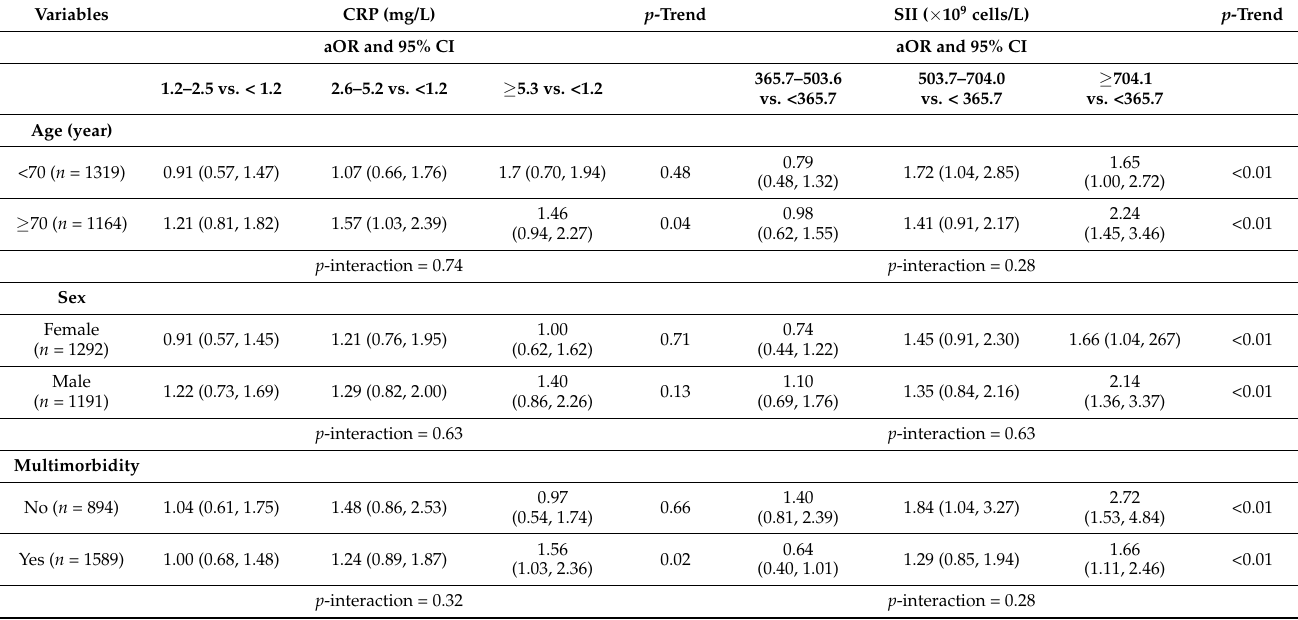
Table 3. Subgroup analysis for association between inflammatory biomarkers and sarcopenia, NHANES 1999–2006 ( n = 2483).